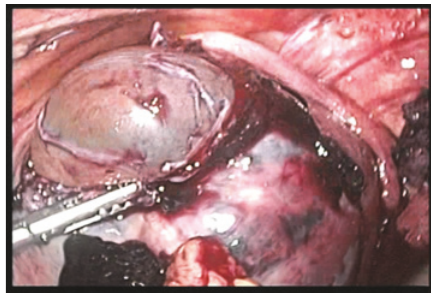
Figure 2: Herniation of the ovular membranes through uterine perforation. Notice intense vascularization surrounding the perfo- ration.